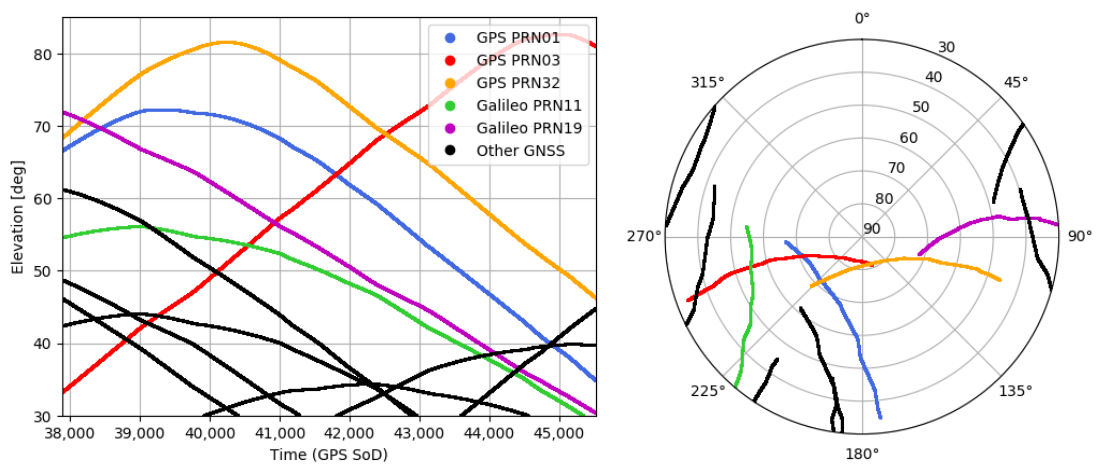
Figure 3. Global navigation satellite system (GNSS) visibility as seen from the receiver during the flight. ( Left ) Evolution of the elevation angle with time. ( Right ) Polar view as a function of azimuth and elevation